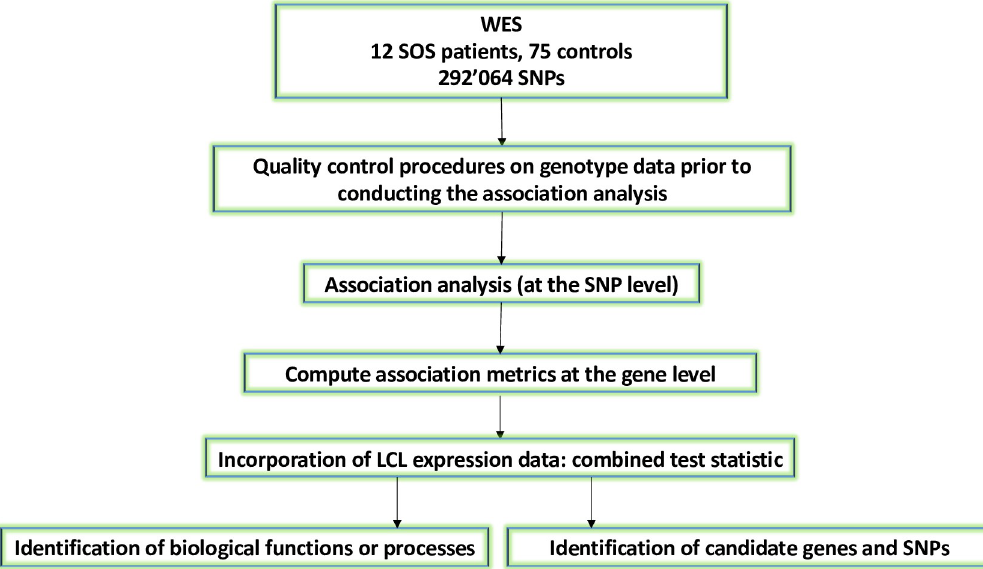
Fig 2. Flowchart of the data analysis pipeline combining whole-exome sequencing of predominantly pediatric patients with in vitro transcriptomic data. Legend: LCL, lymphoblastoid cell line; SNP, single nucleotide polymorphism; SOS, sinusoidal obstruction syndrome; WES, whole-exome